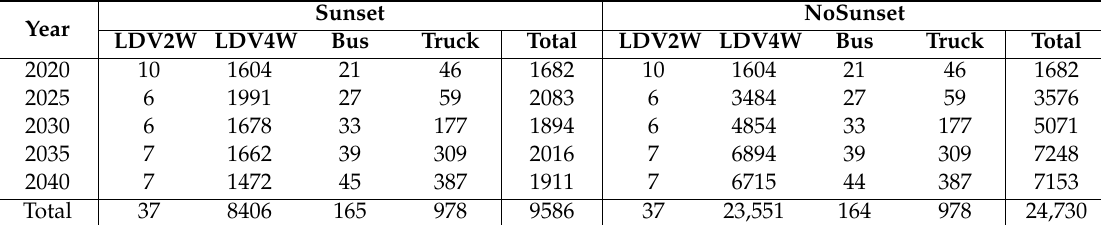
Table 5. Required subsidy by scenarios (unit: Million